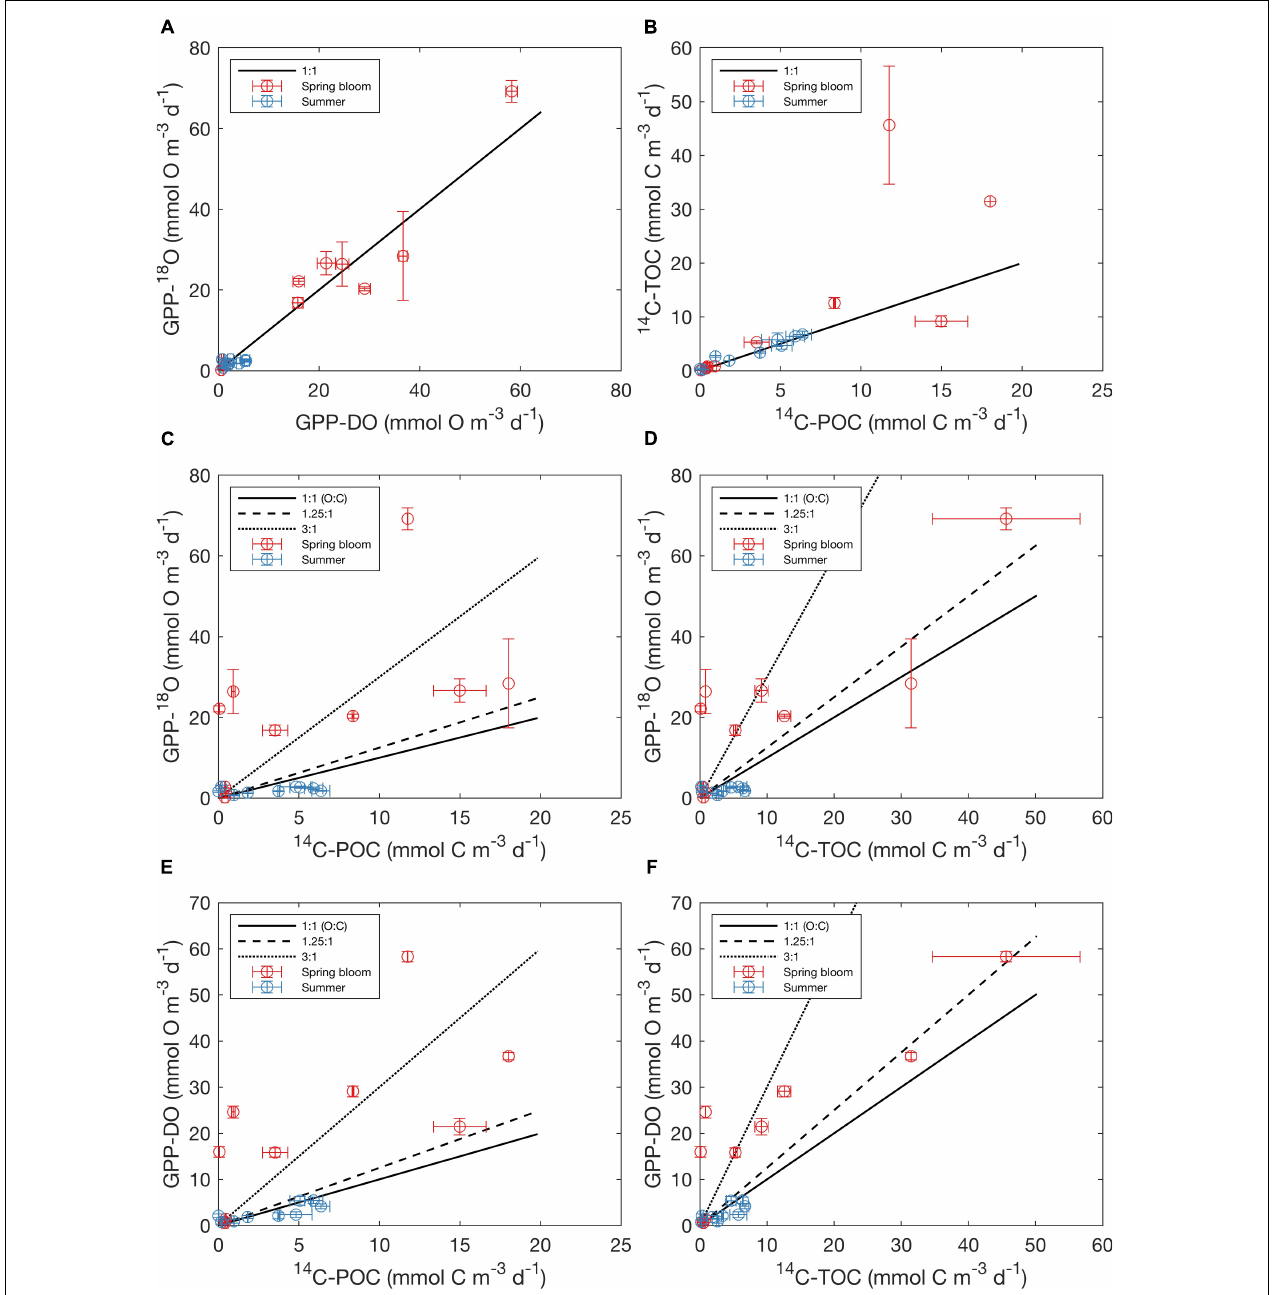
FIGURE 3 | Relationship amongst O- and C-based primary production rates reported in this study, showing mean values (circles) and standard errors on both x and y (error bars). (A) GPP- 18 O vs. GPP-DO, (B) 14 C-TOC vs. 14 C-POC, (C) GPP- 18 O vs. 14 C-POC, (D) GPP- 18 O vs. 14 C-TOC, (E) GPP-DO vs. 14 C-POC and (F) GPP-DO vs. 14 C-TOC. Colors indicate sampling season (the spring bloom in May and summertime in August), with the solid black line indicating a 1:1 relationship, the dashed line 1.25:1, and the dotted line 3:1 (O:C). Note that the rates are untransformed and reported in native units (mmol O m − 3 d − 1 for oxygen and mmol C m − 3 d − 1 for